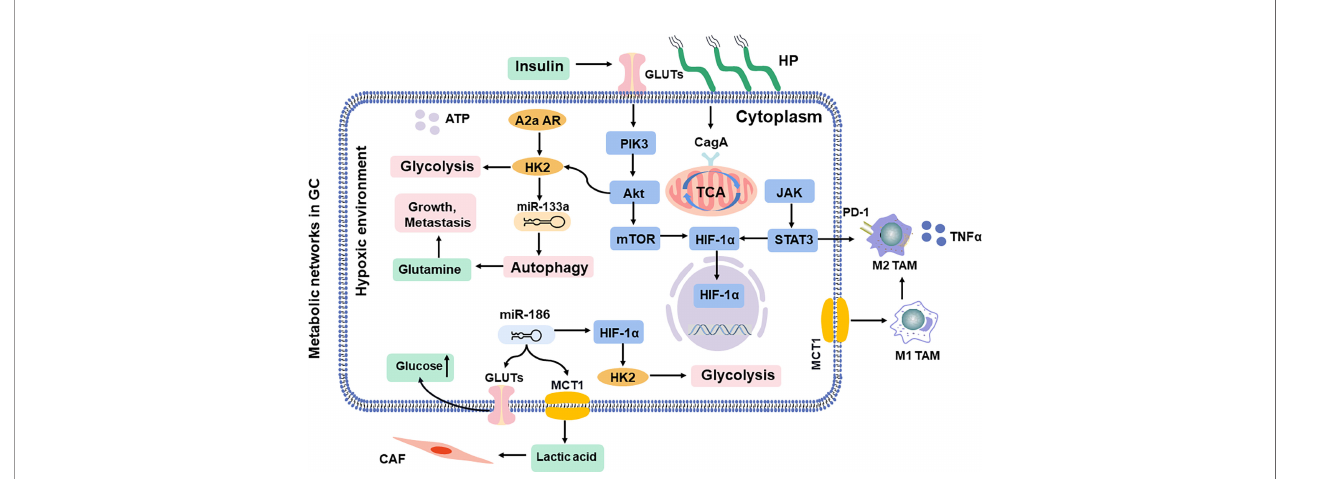
FIGURE 3 | Shift in metabolic networks in GC. The metabolic intermediates of metabolic reprogramming are associated with diverse pathways in the cells inside and outside. HP, H. pylori ; MCT, monocarboxylate channel